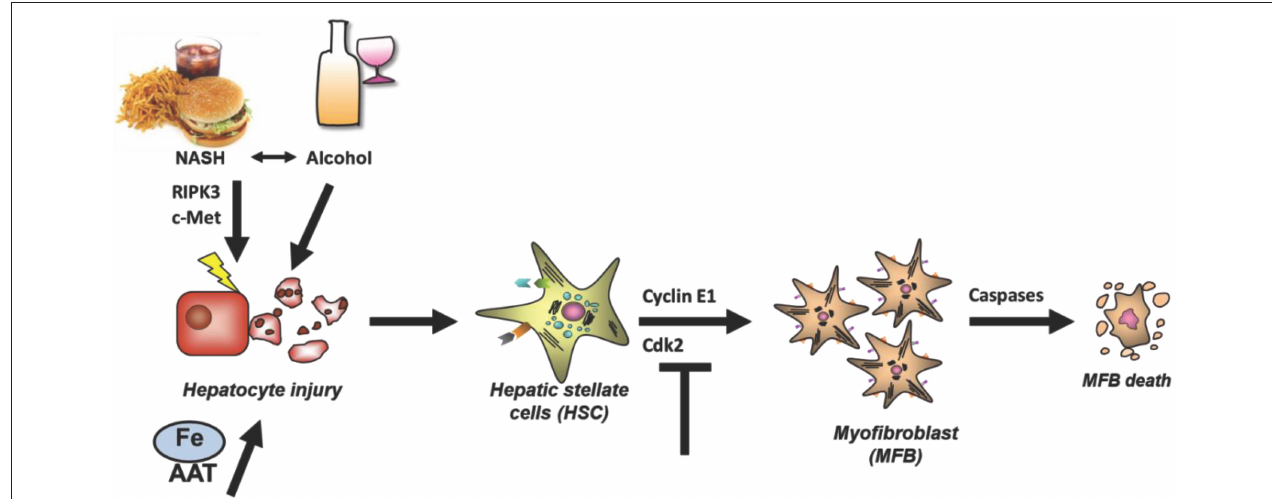
FIGURE 1 | Relevant mechanisms of liver fibrosis initiation reviewed in this article. Four liver-related aspects will be reviewed which aimed to characterize and prevent fibrosis initiation at the level of hepatocyte injury or myofibroblast activation. Hepatocyte injury can be mediated by a variety of mechanisms such as alcohol, NASH, RIPK3-mediated necroptosis, impaired c-Met signaling, iron overload and AAT. In any case, death of hepatocytes triggers activation of HSCs and their transdifferentiation and proliferation of Myofibroblasts. The latter process depends on the cell cycle regulator Cyclin E1 and its interacting kinase Cdk2. It is hypothesized that fibrosis can be halted by inducing Caspase-mediated MFB cell death. AAT, α 1-antitrypsin; AAT-d, α 1-antitrypsin-deficiency; DAMPs, Danger-associated molecular patterns; Fe, Iron overload; NASH, non-alcoholic